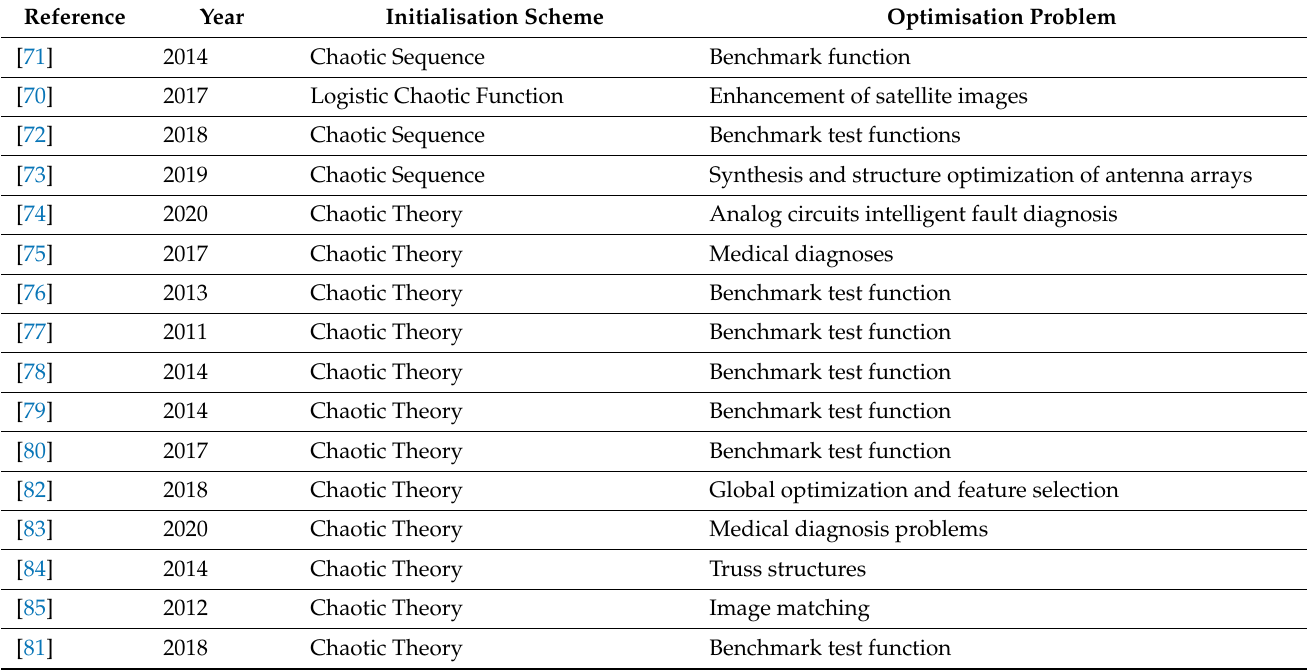
Table 5. Summary of chaotic based